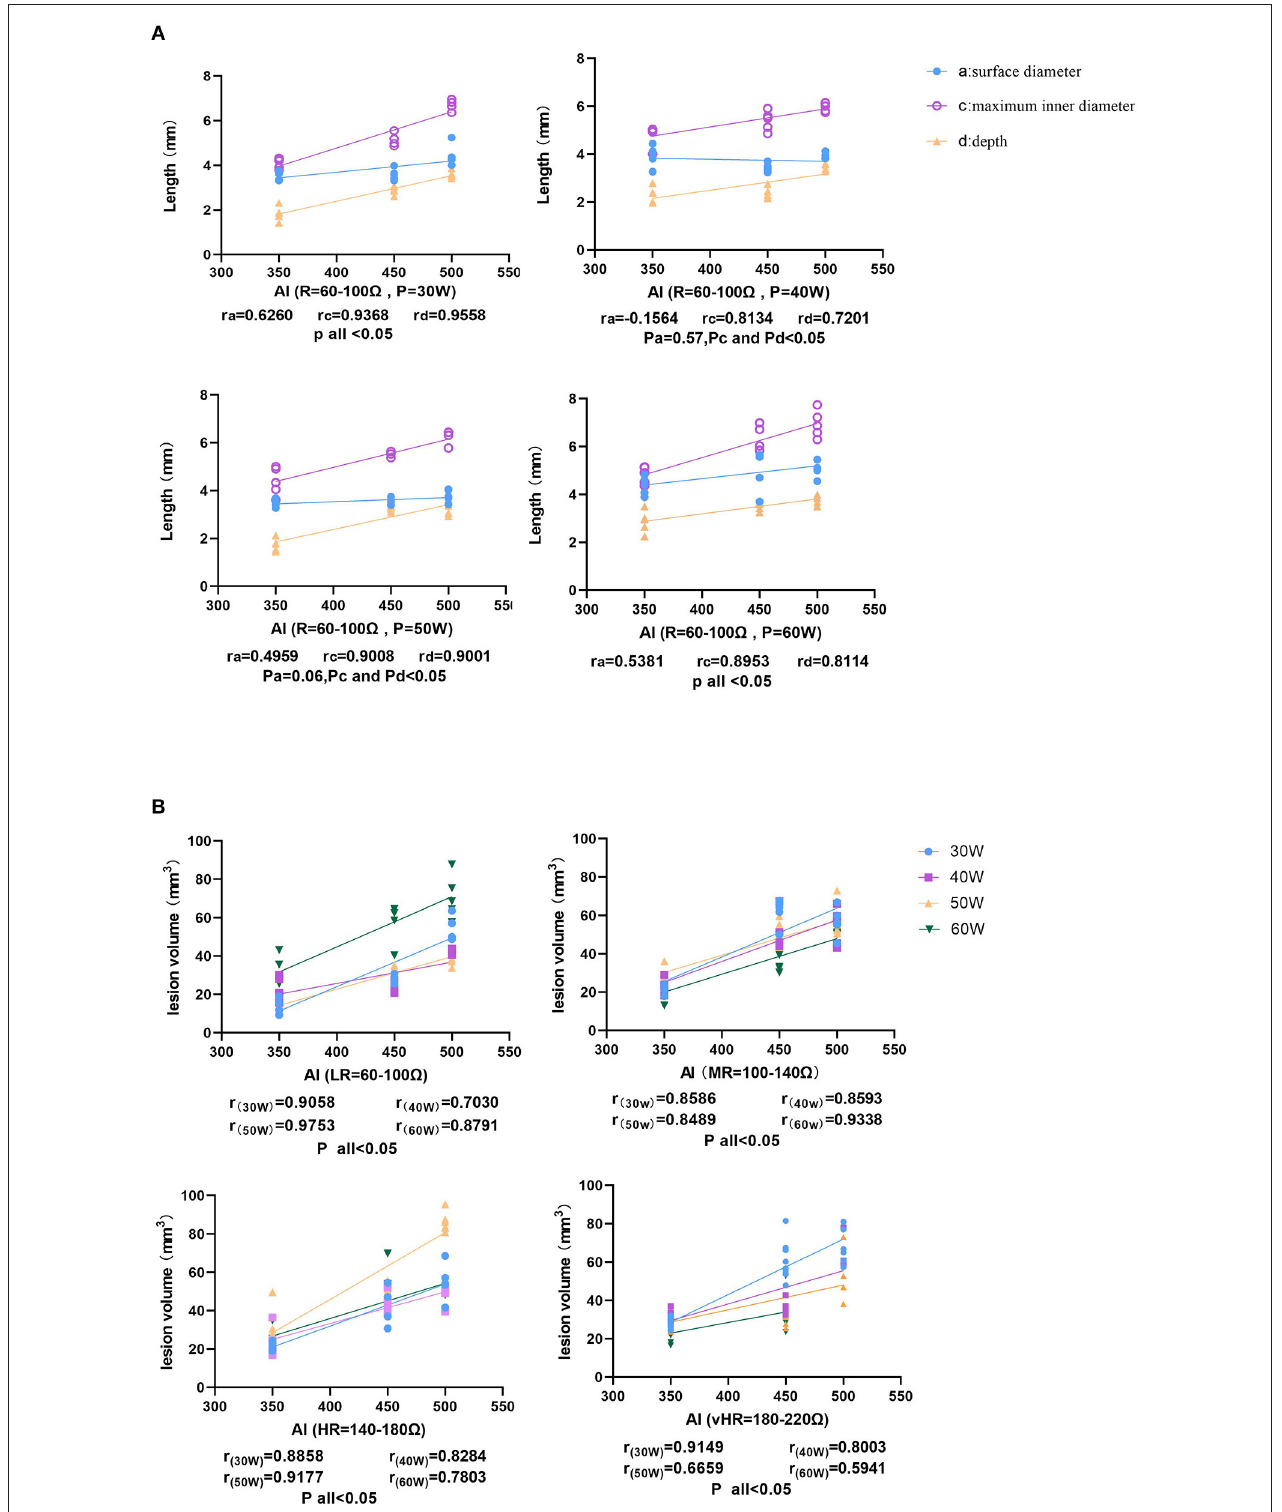
FIGURE 3 | The correlation between ablation index (AI) and lesion characteristics. (A) The size of the ablation lesions at the same baseline R (60–100 Ω ) and different P settings (30, 40, 50, and 60W), showing that the surface diameter of the ablation lesions increases with AI, the maximum inner diameter, and the depth, showing an increasing trend. (B) The relationship between volume and AI at different baseline